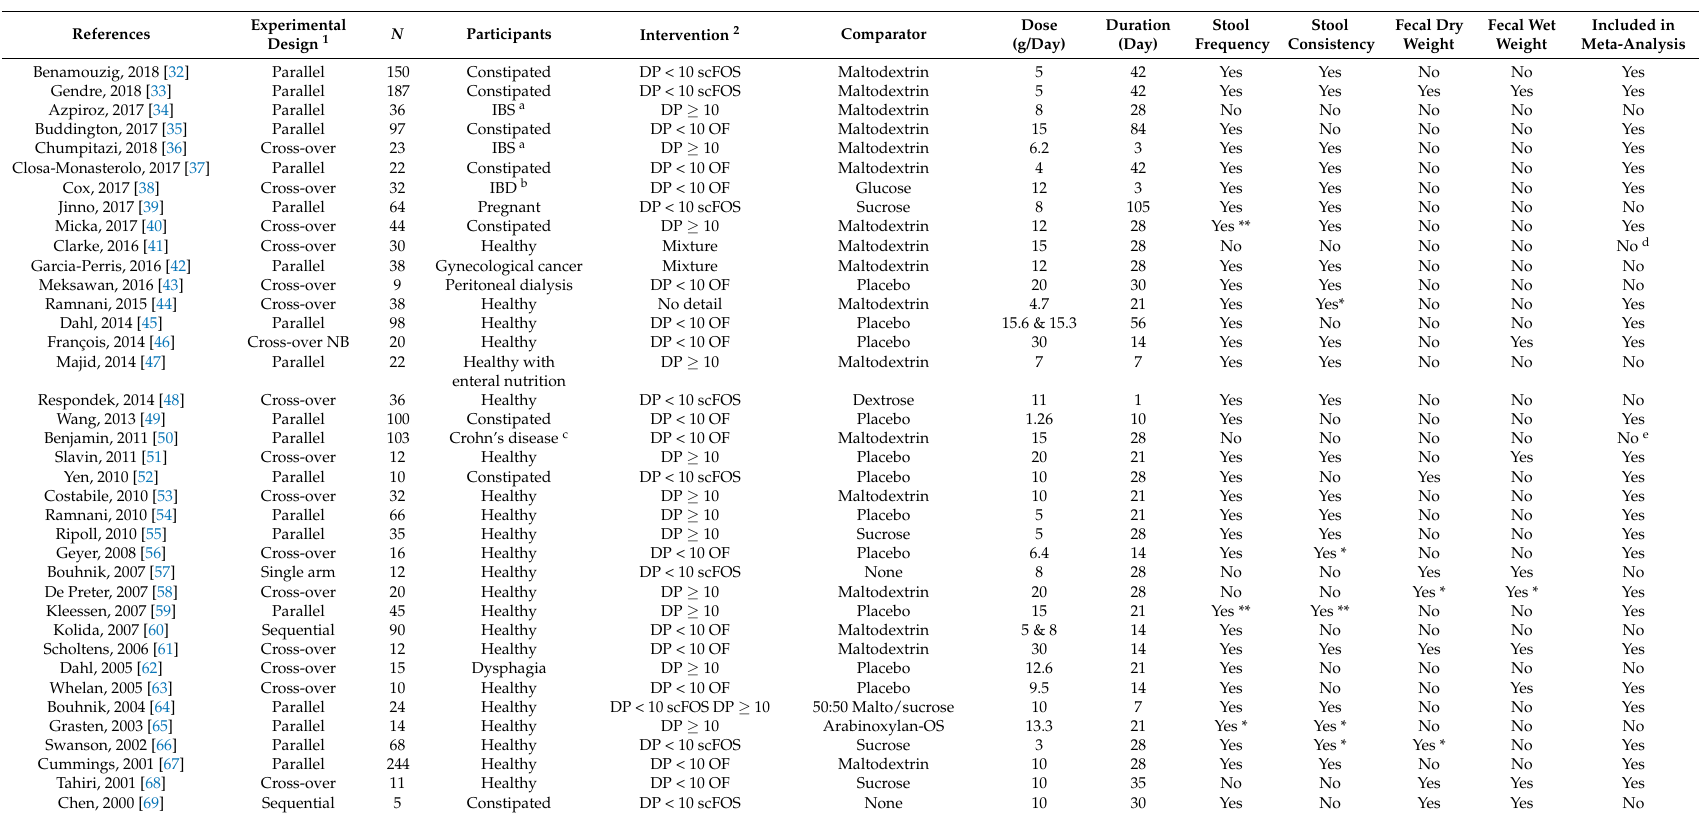
Table 1. Characteristics of all publications in